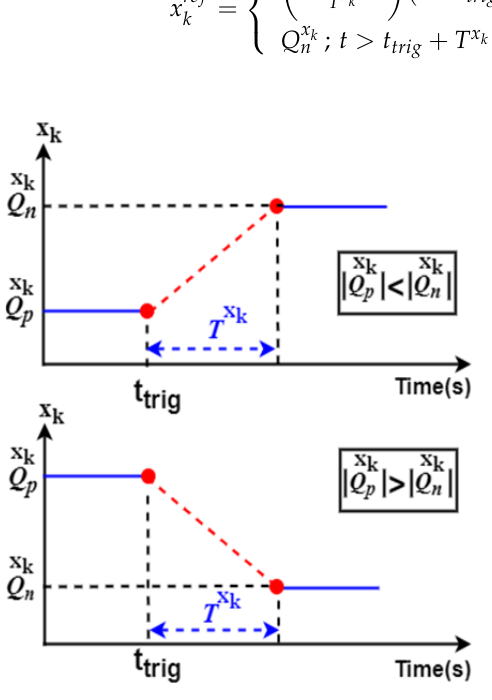
Figure 5. Linear-based transition function.